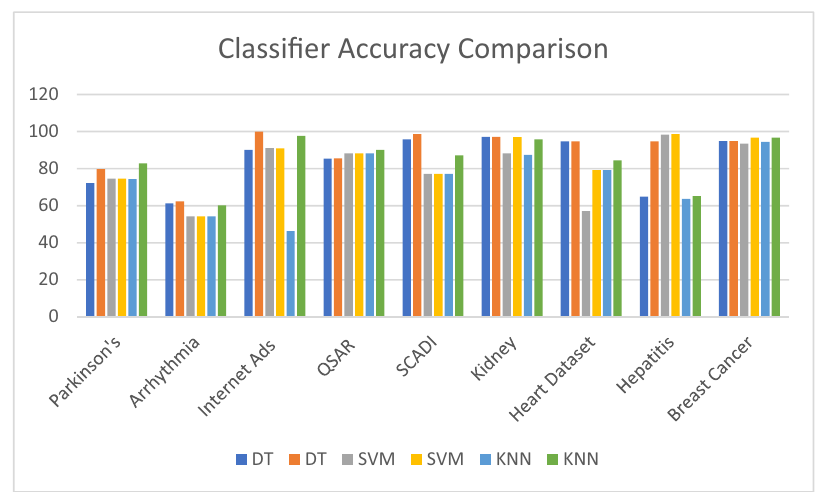
Figure 3: Comparison of accuracy of FrbyCC and PCA with DT KNN SVM classi fi er.